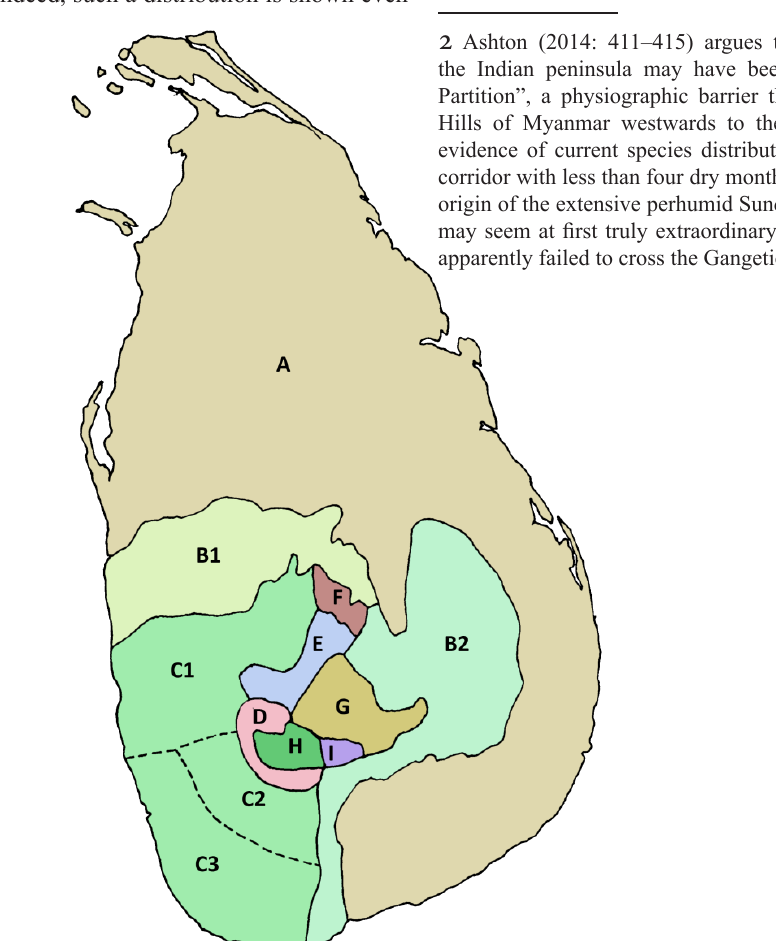
Figure 2: Floristic zones of Sri Lanka; adapted from Ashton et al ., (1997). A: Dry zone; B1: Northern Intermediate lowlands; B2: Eastern Intermediate lowlands; C1: Northern Wet lowlands; C2: South of Ratnapura - Northern Sinharaja; C3: Southern Sinharaja- Hiniduma-Kanneliya; D: Foothills of Adam’s Peak North of Ratnapura-Ambagamuwa; E: Kandy - upper Mahaweli; F: Knuckles; G: Central Mountains Ramboda - Nuwara Eliya; H: Adam’s Peak; I: Horton